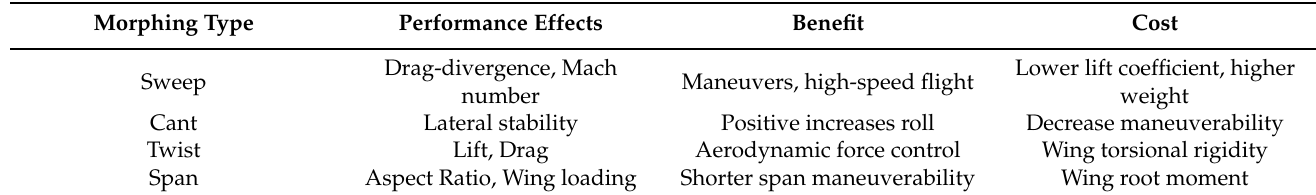
Table 1. Wing Morphing and its